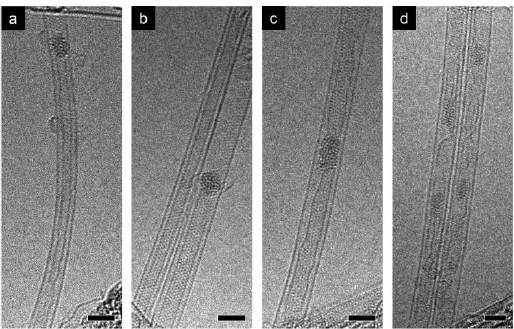
Figure 1. Transmission electron microscopy of cobalt clusters annealed at 550 °C for 2 h: ( a,b ) an inner tube; ( c,d ) metal clusters with graphitic structures. Scale bars, 2 nm. Reprinted from Kharlamova, M.V., et al. Chiral vector and metal catalyst-dependent growth kinetics of single-walled car- bon nanotube, Carbon. 2018. V. 133. P. 283-292, Copyright (2018), with permission from Elsevier [98].